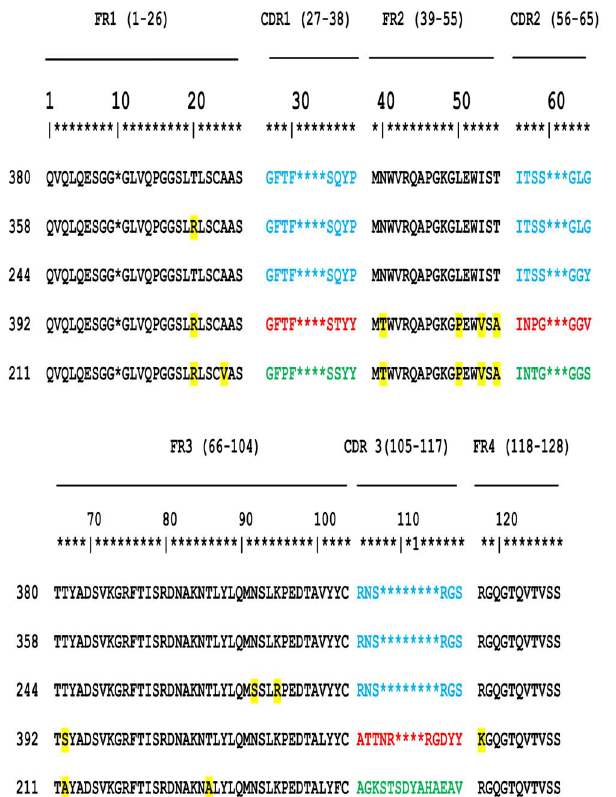
Fig. 1. Sequence alignment of deduced amino acid. Sequences of the different cross-reactive nanobodies highlighting the framework (FR) and complementarity determining region (CDR) sequences. CDR sequences are highlighted in blue, red and green (corresponding to different families), while FR differences are marked in yellow. The guidelines of the international Immunogenetics information system of numbering are used (http:/